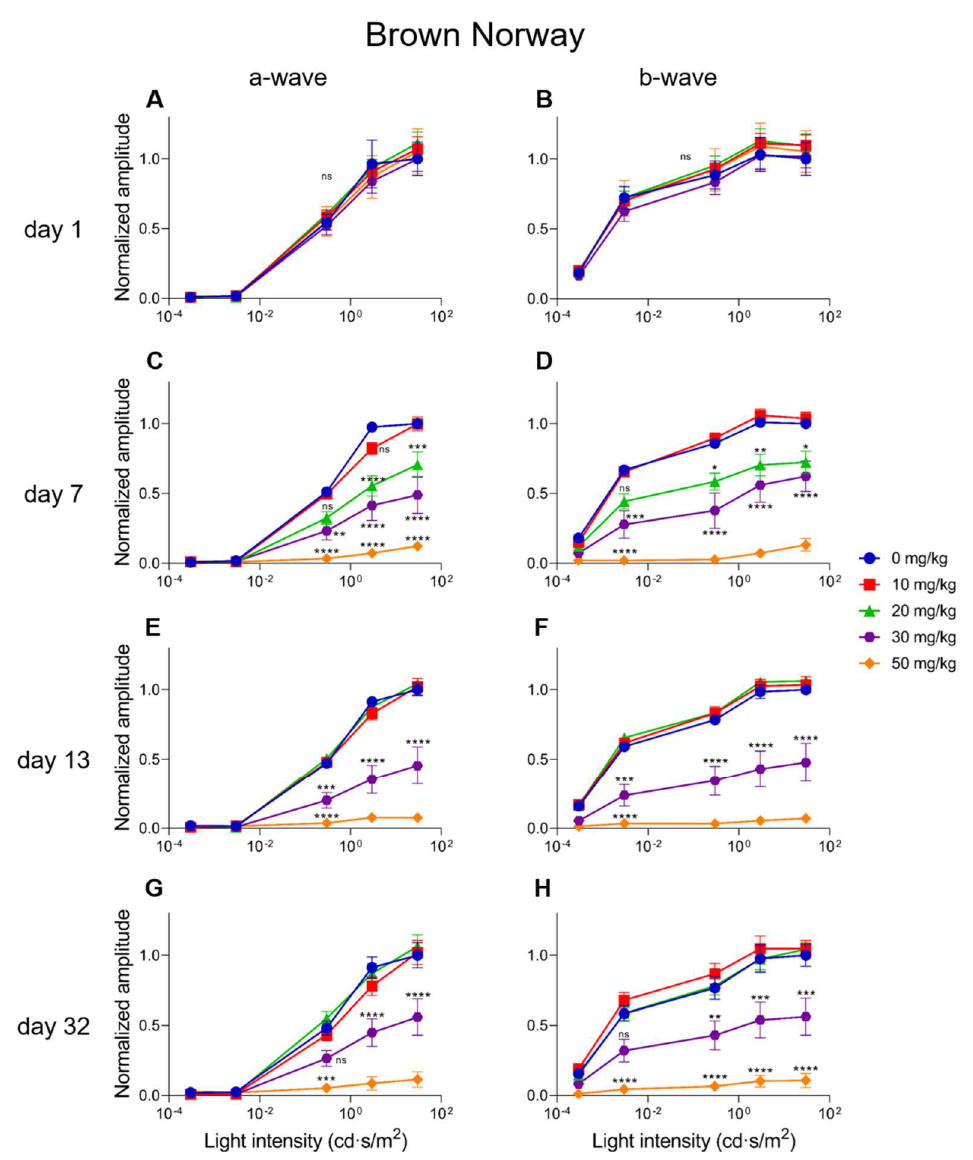
Figure 9. The normalized a-wave ( A , C , E , G ) and b-wave ( B , D , F , H ) amplitudes are plotted versus the light intensity for all the treatment groups in Brown Norway rats ( n = 4 per group). The amplitudes are shown ± the standard deviations. No significant differences could be observed at day one (baseline) between all the treatment groups. The treatment effects started to show from seven-days post-injection onwards. A significant and clear effect was observed for the 20 mg/kg treatment group for both the a- and b-wave. A 30 mg/kg dose caused moderate effects, and 50 mg/kg caused more extreme decreased amplitudes. From day 13 onwards, more long-term effects were visible. No significant differences were observed (anymore) between the control, 10 mg/kg, and 20 mg/kg groups. A significant, stable, and moderate effect was observed for the 30 mg/kg treatment group. Injection of 30 mg/kg SI caused a reduction of the a- and b-wave amplitudes of roughly 50% at least up to one-month post-injection. More extreme effects were observed for the higher dose (50 mg/kg). Almost non-recordable ERG responses were observed in this group. ns: not significant, *: p ≤ 0.05,